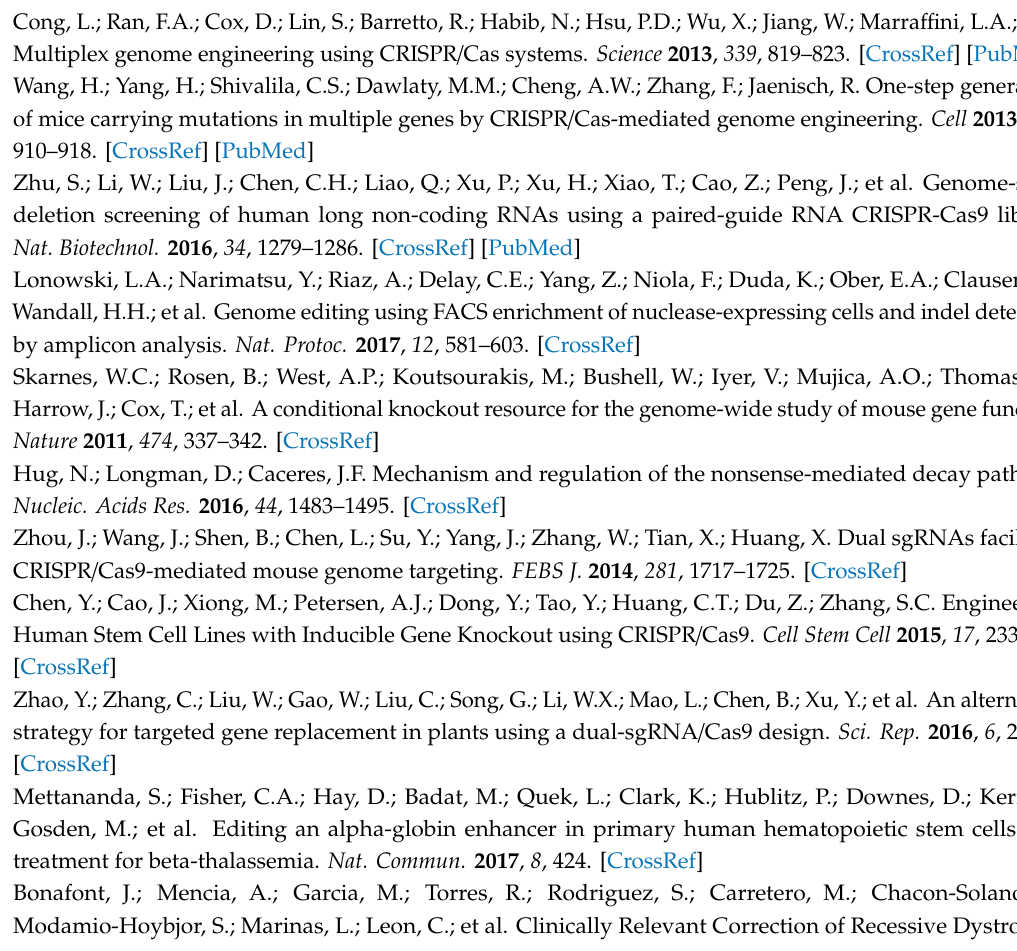
Table S1: List of all oligonucleotides used in this